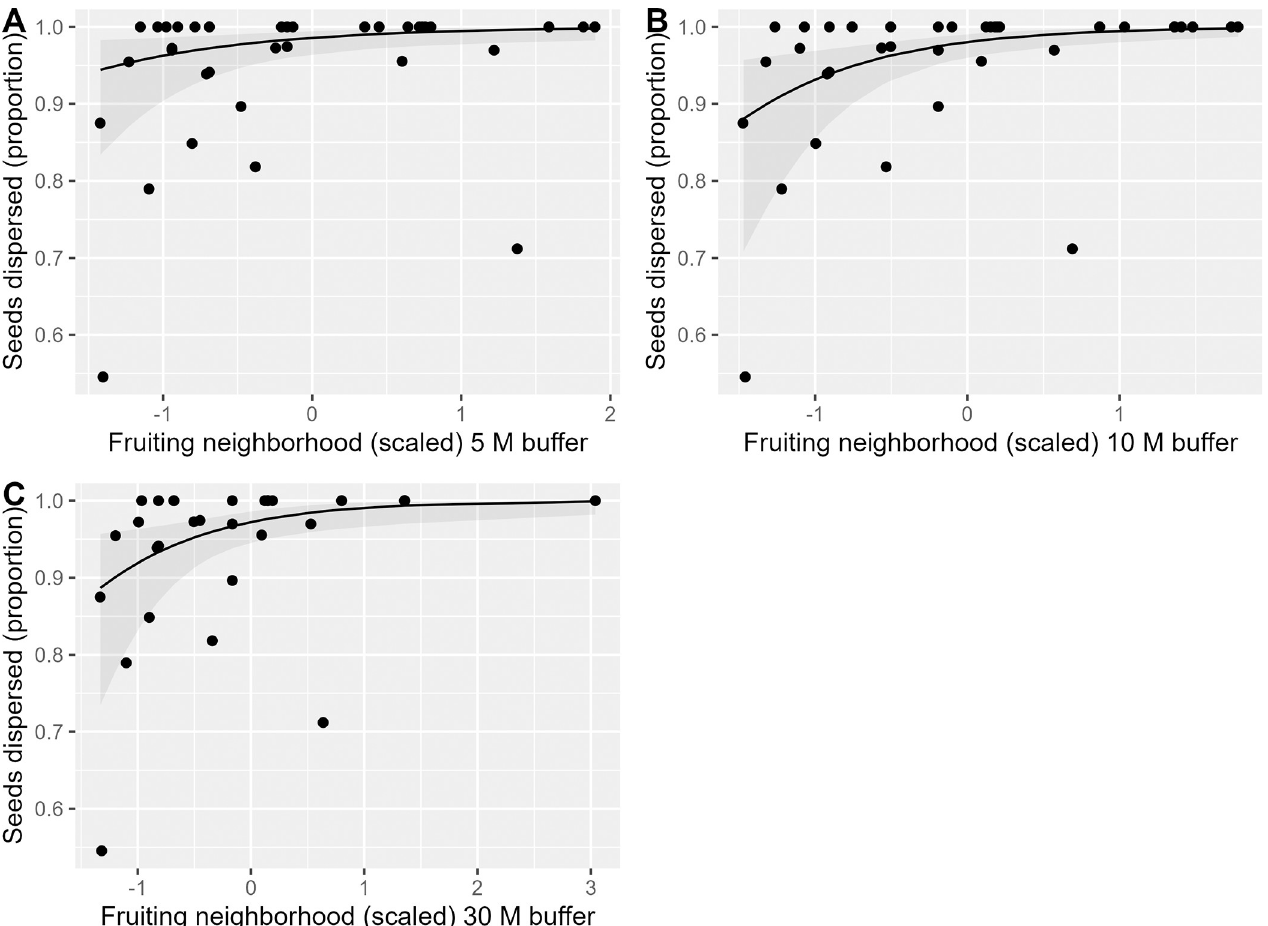
Fig 4. Relationship between proportion of Lindera subcoriacea seeds dispersed and fruiting neighborhoods (scaled and centered) within (A) 5 m, (B) 10 m, and (C) 30 m radius nested buffers. Points are individual observations, the lines are from mixed-effects generalized linear regression models (reduced models), and the shaded regions are 95% confidence